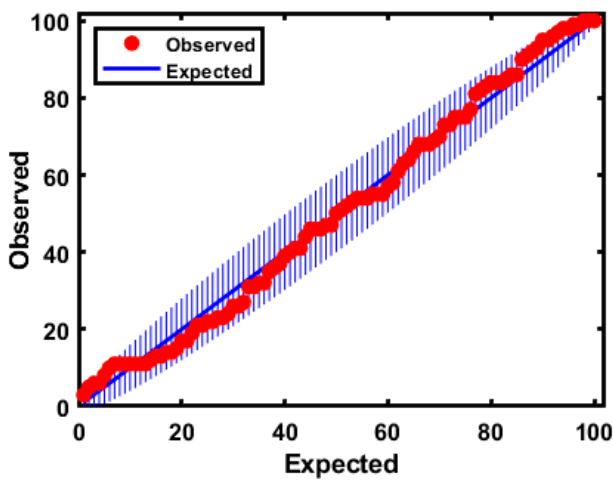
Figure 8. Extreme plot for the calibration set based on the model based on FT-IR.